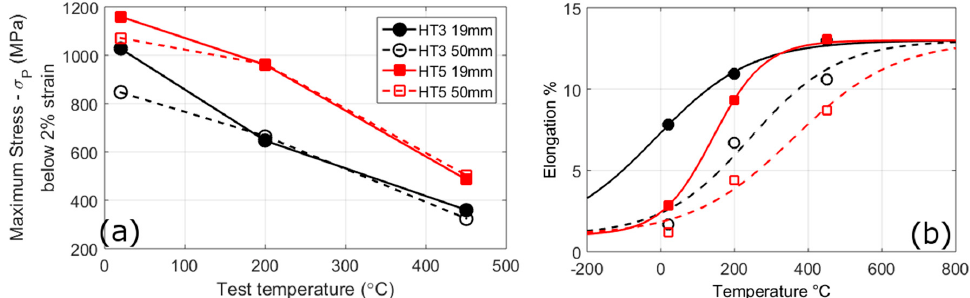
Figure 6. The change in yield stress ( a ); and elongation to failure ( b ) with temperature for the different conditions. σ P is the strengthening by precipitation of HT3.